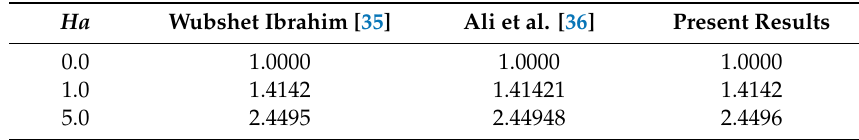
Table 1. Comparison of solution for f (cid:48)(cid:48) ( 0 ) with various values of Ha when K = λ = Rb = Rc = Γ = α = β =